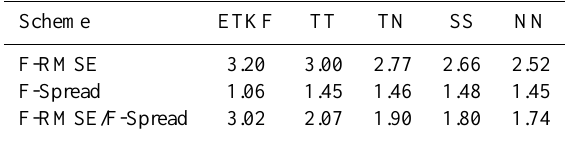
Table 2. The time-mean values of F-RMSE and F-Spread, and the ratio of F-RMSE to F-Spread in the four ETKF schemes for the Lorenz 96 model, with forcing parameter F = 12 and parameter of observation operator α = 0 . 1.